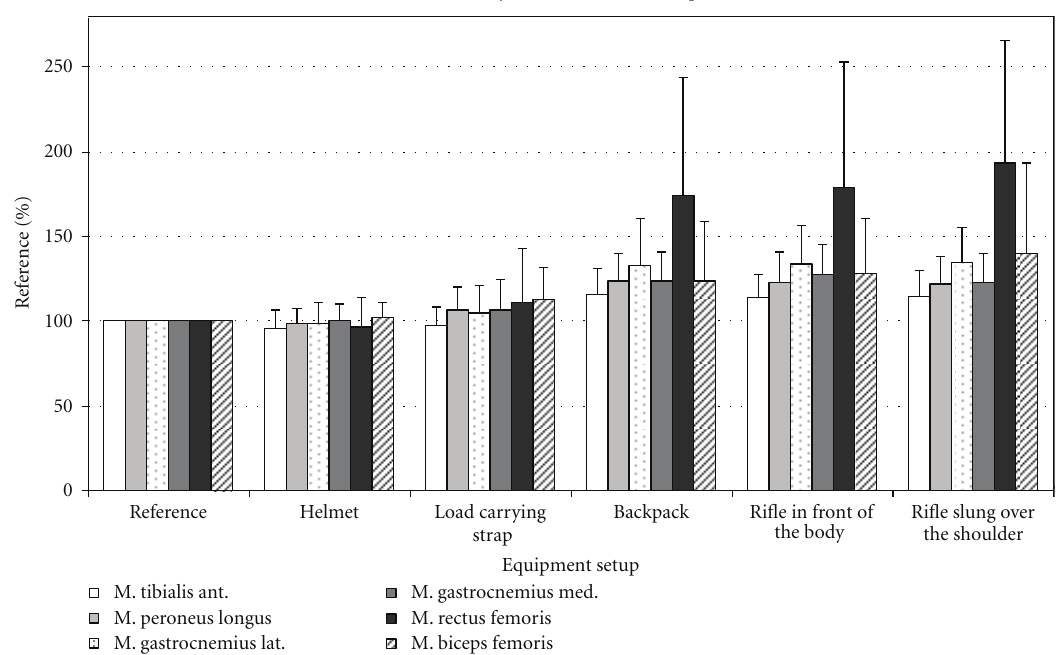
Figure 2: Mean EMG amplitude in percent compared to the mean EMG of the reference